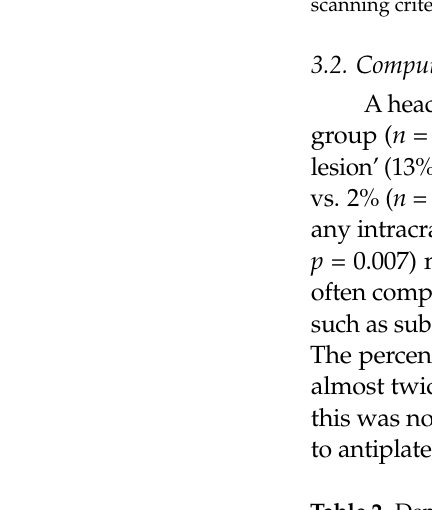
Table 2. Demographics and trauma characteristics of intracranial lesions after MHI in elderly